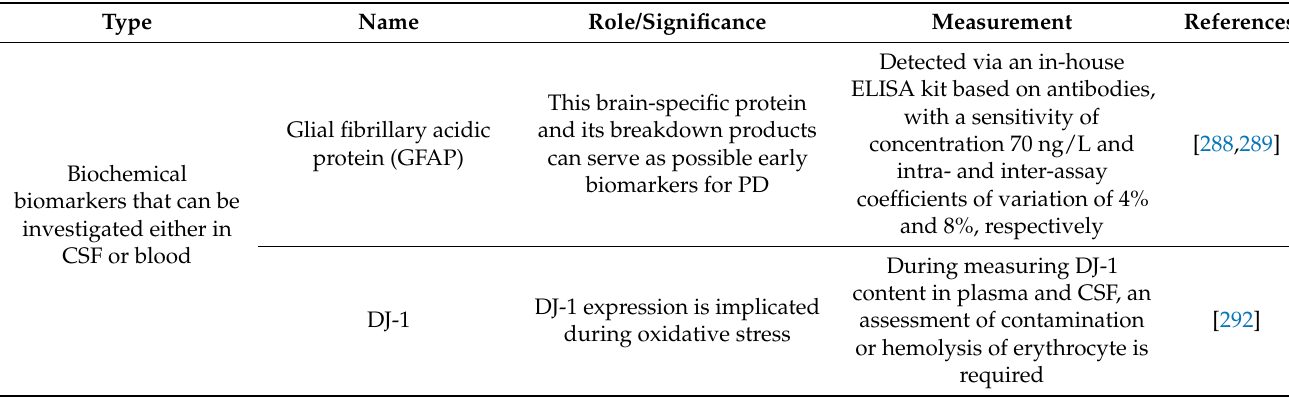
Table 5. Proposed molecular biomarkers for PD